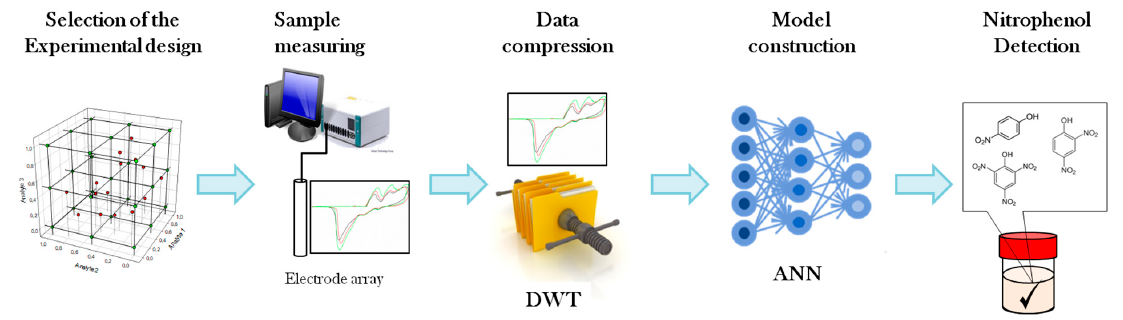
Figure 2. Scheme of the strategy followed in the resolution of nitrophenol-related compounds.